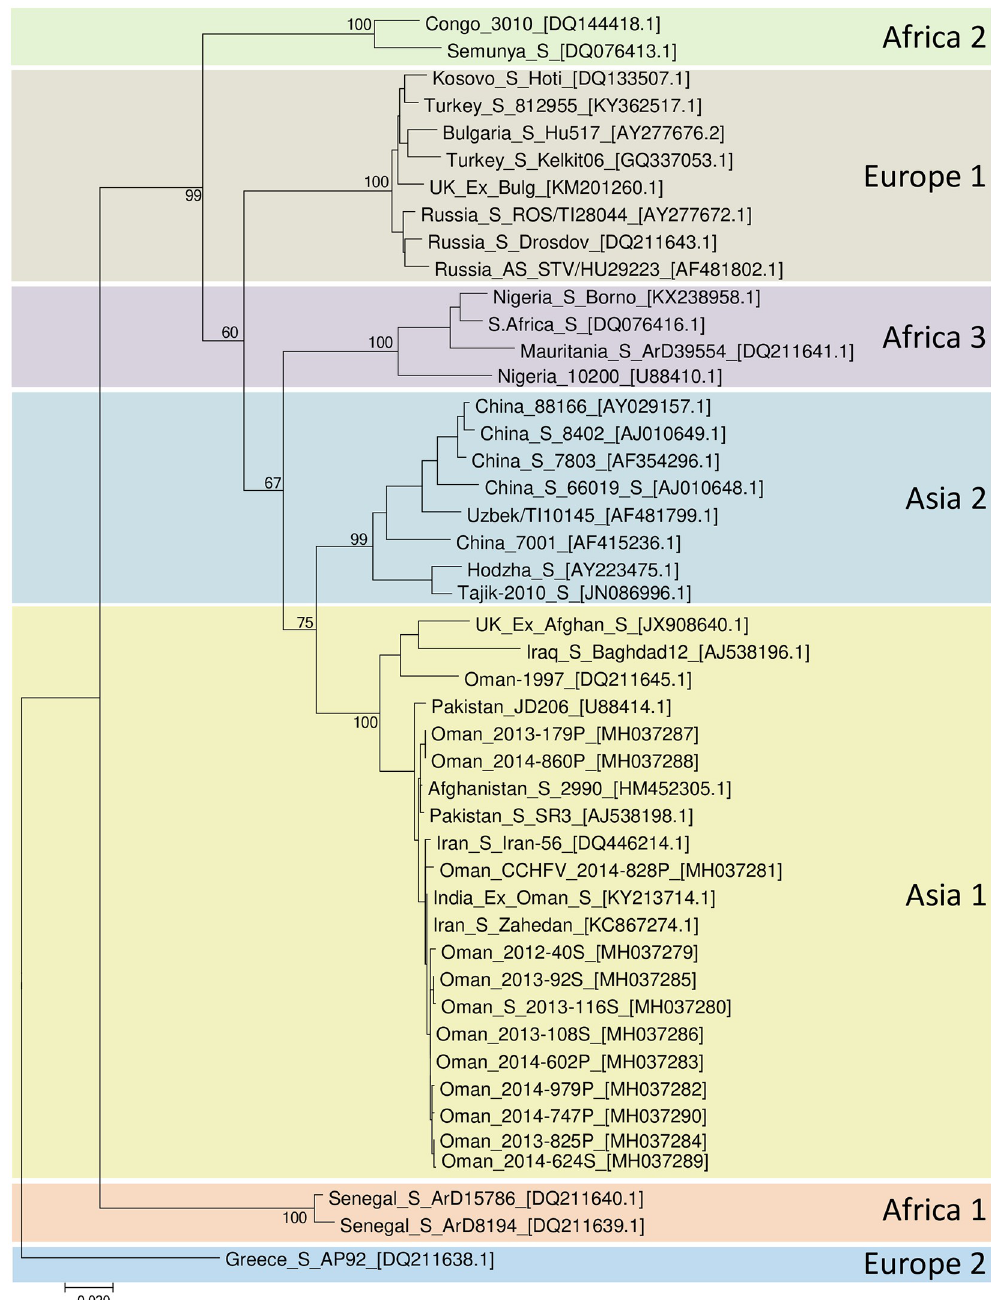
Fig 4. Phylogenetic tree showing Omani sequences clustering in Asia 1 lineage, with other sequences from the GCC region previously deposited in